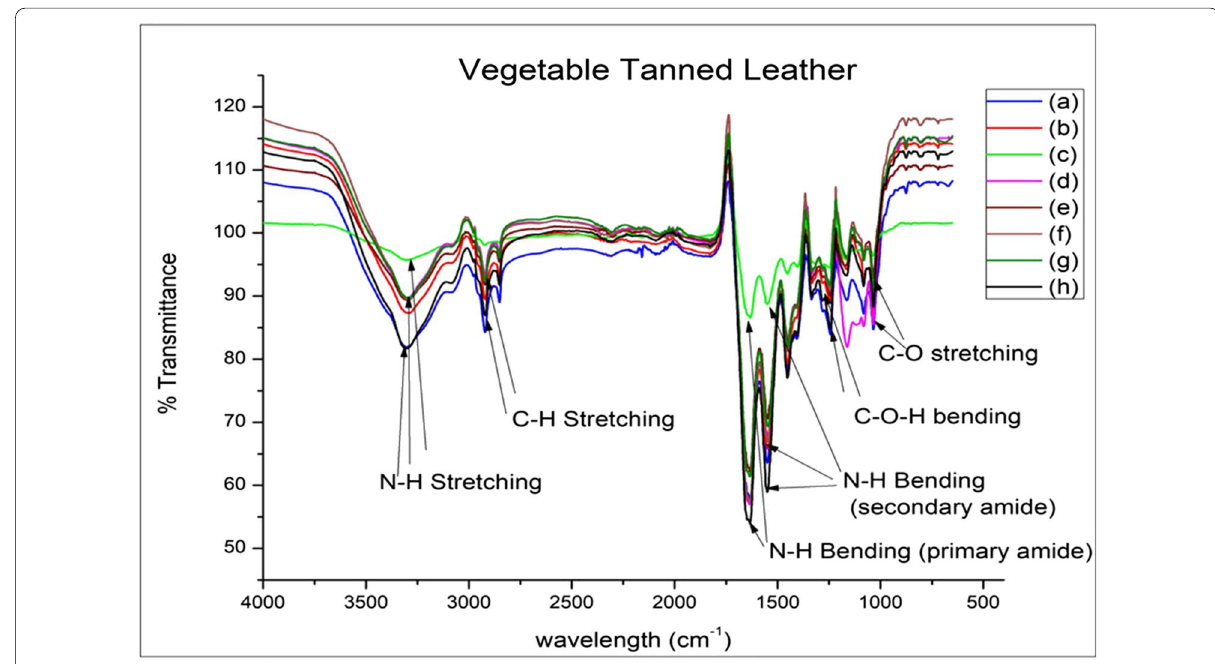
Fig. 3 FT-IR spectra of vegetable tanned leather samples after 30 days’ incubation a control sample without fungi and UV exposure, b A. niger infected leather, c A. flavus infected sample, d control sample with only UV-C exposure for 60 min, e sample exposed for 60 min of UV-C and initially infected by A. niger , f sample exposed for 15 min of UV-C and initially infected by A. niger , g 60 min of UV-C exposure and initially infected by A. flavus sample and h sample exposed for 15 min of UV-C exposure and initially infected by A.